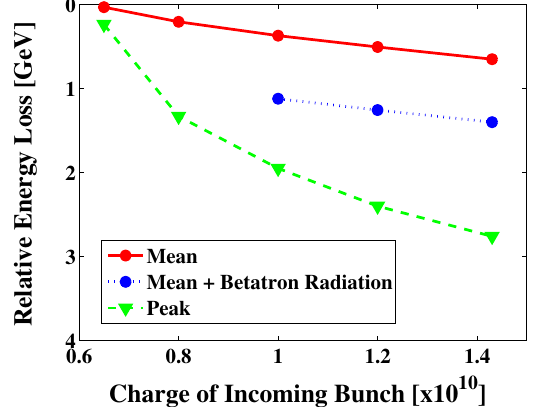
FIG. 11. (Color) Changing beam size (Li)—The average and peak energy loss results from OOPIC .